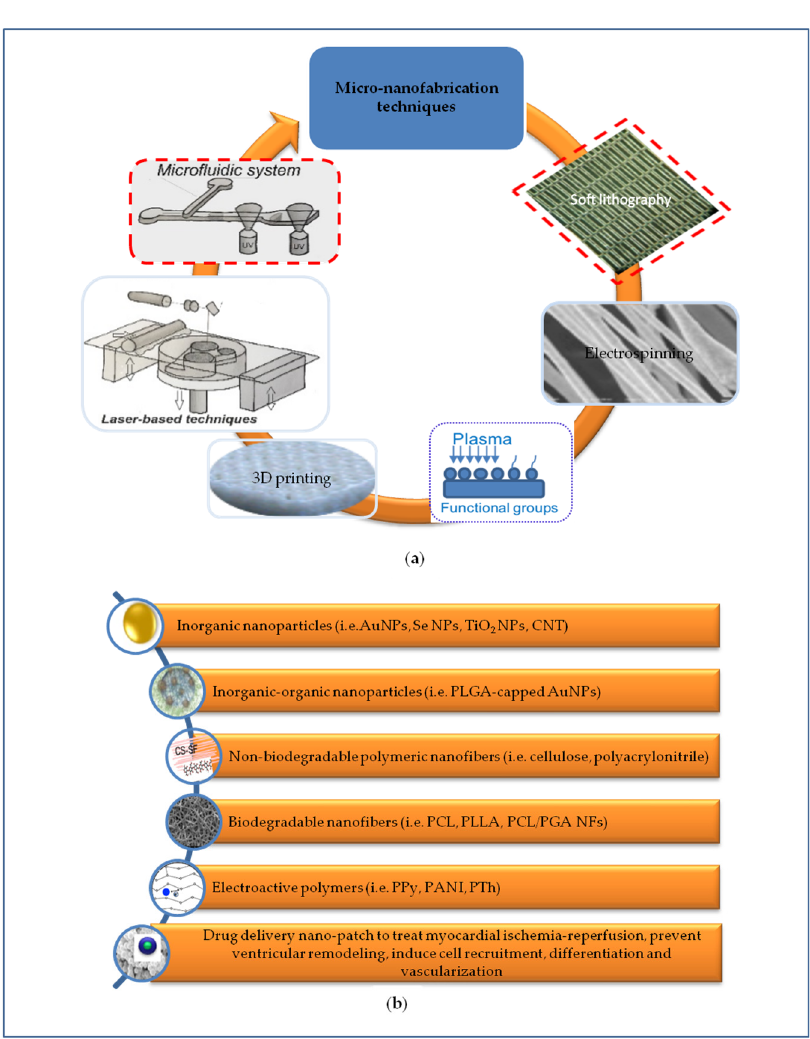
Figure 2. Representation of different micro-nanoengineering approaches to develop scaffolds recapitulating the complex signals necessary for cardiac regeneration. ( a ) Micro-nanofabrication techniques are crucial to produce scaffolds mimicking the anisotropic micro-nanostructure and mechanical properties of native cardiac ECM; ( b ) Micro-nanostructured scaffolds based on non-biodegradable and/or biodegradable polymers were further implemented by incorporating electrically conductive nanomaterials to provide relevant electro-mechanical stimulation. Implementing cardiac patch with drug delivery systems using different methods can help to treat simultaneously myocardial ischemia-reperfusion, to prevent left ventricular remodeling and to induce cardiac regeneration processes.